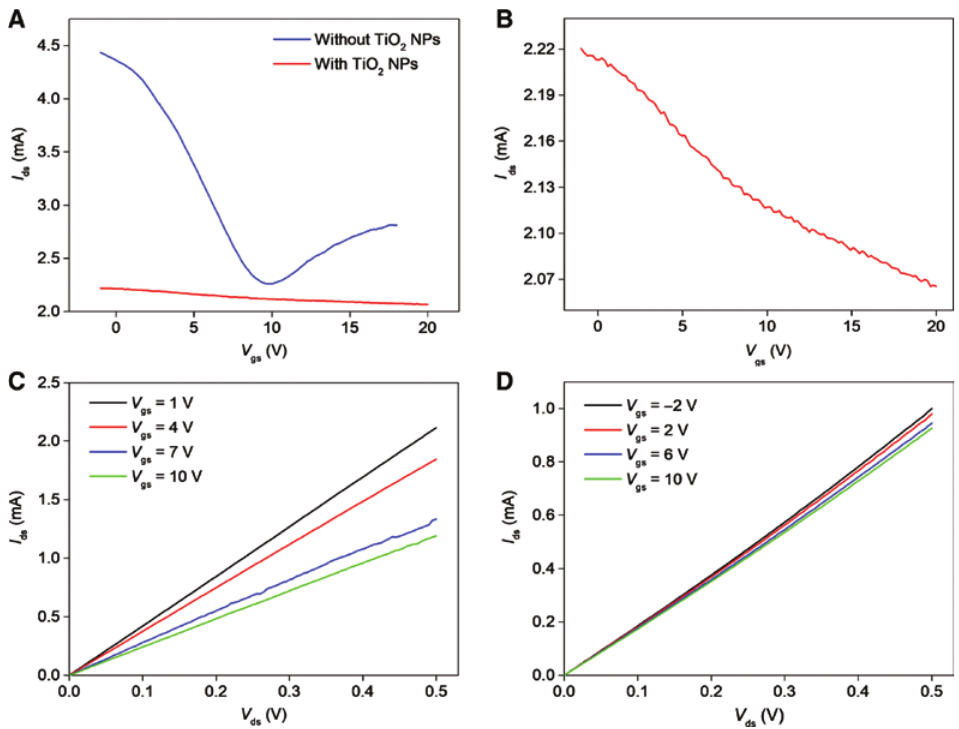
NPs decoration process. 2 NPs. (B) The transfer characteristic of 2 NPs, 2